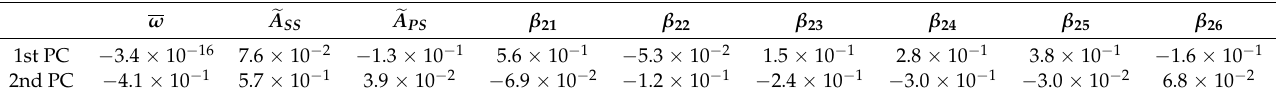
Table 4. The 1st and 2nd principal component of objective space